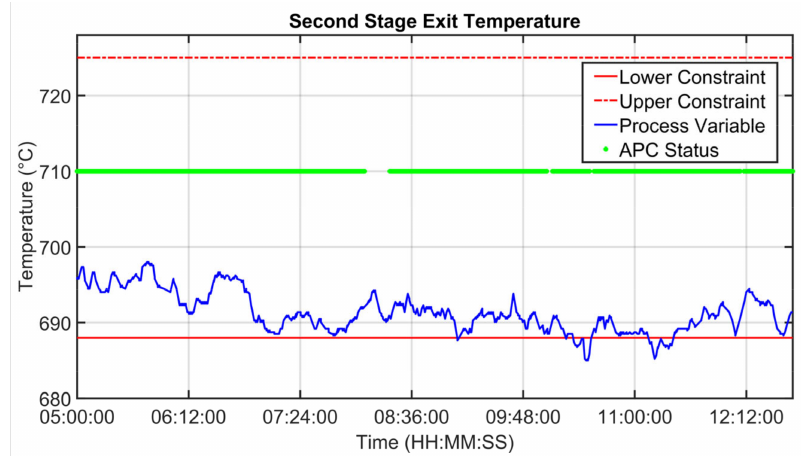
Figure 20. Rotary kiln APC system: field results (second-stage exit temperature CV).